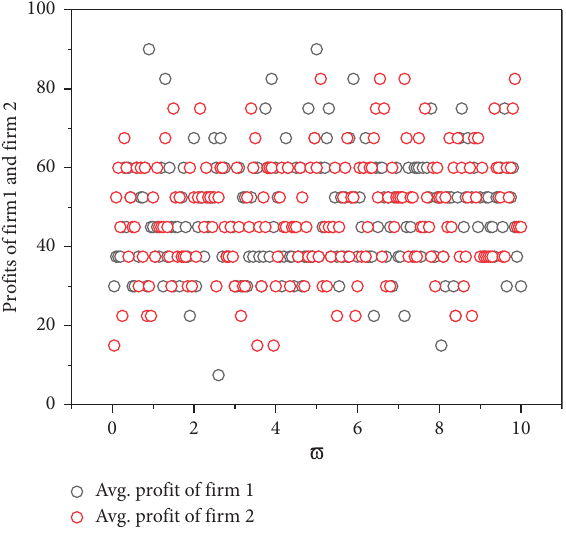
Figure 7: Marketing strategy optimization